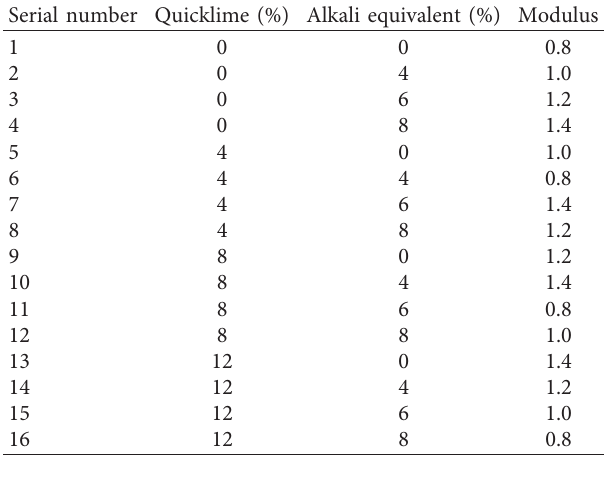
Table 2: Orthogonal experimental table of slurry ratio.